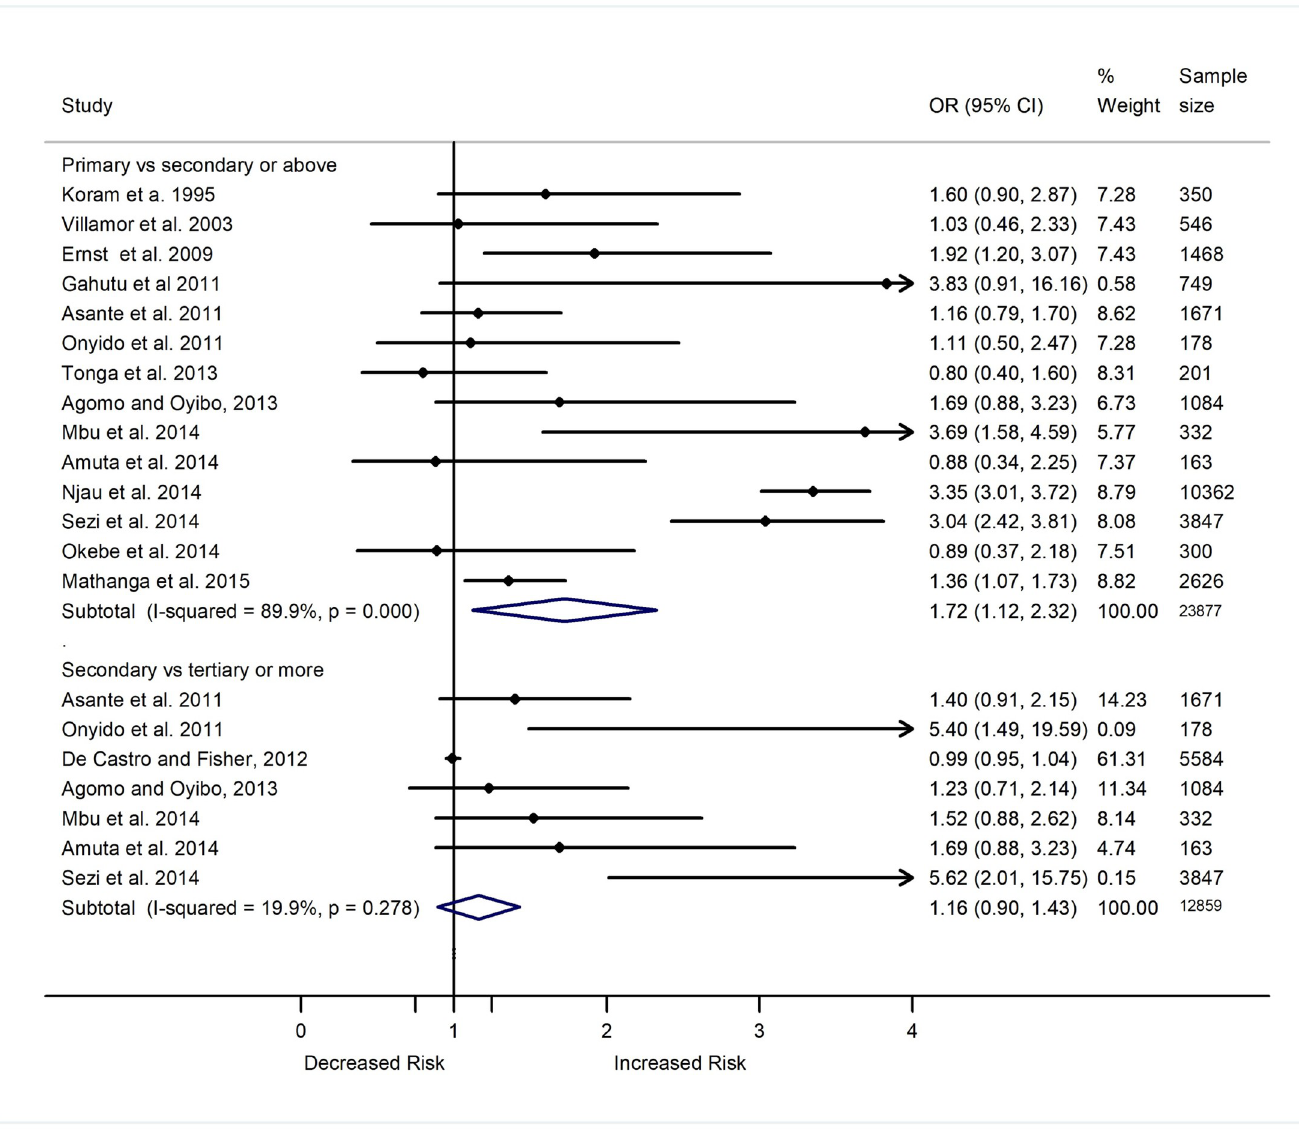
Fig 5. Forest plot comparing the odds ratio of Plasmodium infection between individuals with primary education level versus those with secondary or more, and those with secondary versus tertiary or more education level Subtotal (summary) ORs estimated using random effect models when I 2 � 30 and using fixed effect models when I 2 < 30. Weights estimated using inverse variance method. I 2 , a measure of heterogeneity.